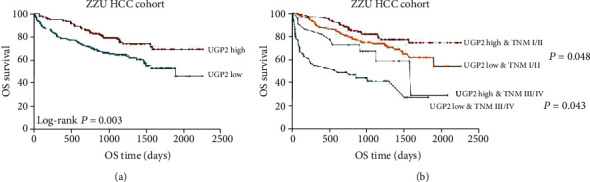
Downregulated UGP2 expression predicts a poor prognosis in HCC patients in the ZZU cohort. (a) Kaplan-Meier survival curves showing the correlation between UGP2 expression levels and the OS of HCC patients in the ZZU cohort. (b) Kaplan-Meier analysis revealed that OS was short in HCC patients in the ZZU cohort with low UGP2 expression levels regardless of the TNM stage. UGP2: uridine diphosphate-glucose pyrophosphorylase 2; HCC: hepatocellular carcinoma; OS: overall survival; TNM: tumour-node-metastasis.